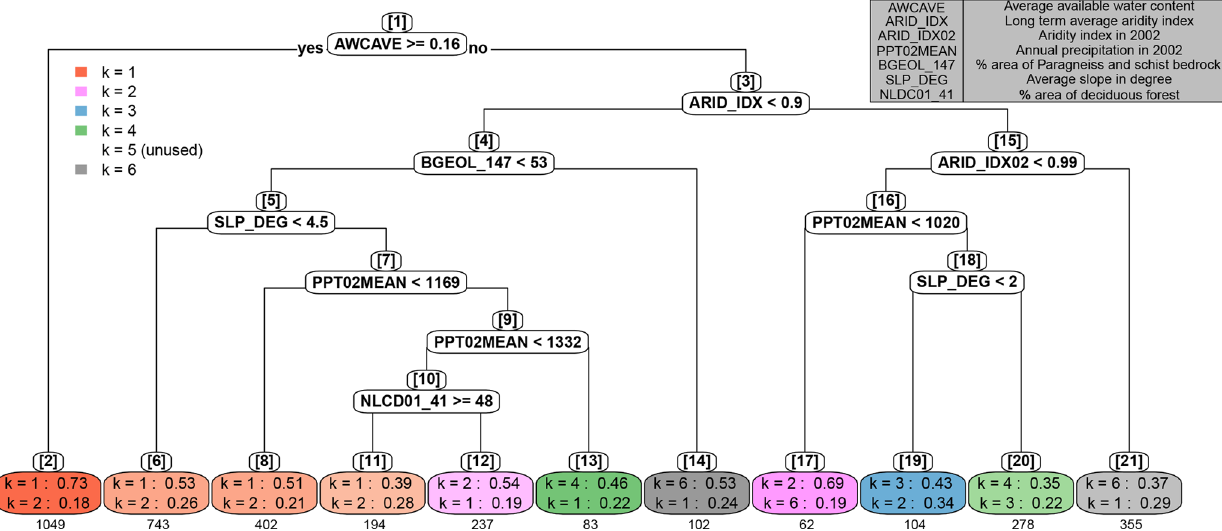
Figure 9. CART model classifying the RMSE labels of the testing watersheds. Splitting rules are shown in white nodes, while leaf nodes are colored based on the classification results. For each leaf node, the brightness of the coded color indicates the node impurity (the brighter the more impure), where impurity is defined as the probability that two randomly chosen watersheds within the node have different labels. On top of every node, in brackets, is the node number, provided for convenient referencing. The predictors in the splitting rules are expressed in code names for convenience; a reference table is provided in the upper right. For each leaf node, the model of the highest multinomial probability of having the best performance is shown first, which also determines the classification result, followed by the model of the second highest probability, also to indicate the impurity. Underneath each leaf node box is the number of watersheds belonging to the leaf. Note that the legend does not include benchmark because the benchmark model is never the best-performing model at any testing watershed. k = 5 is marked as “unused” in the legend because there is no leaf node where p(B 5 ) is the